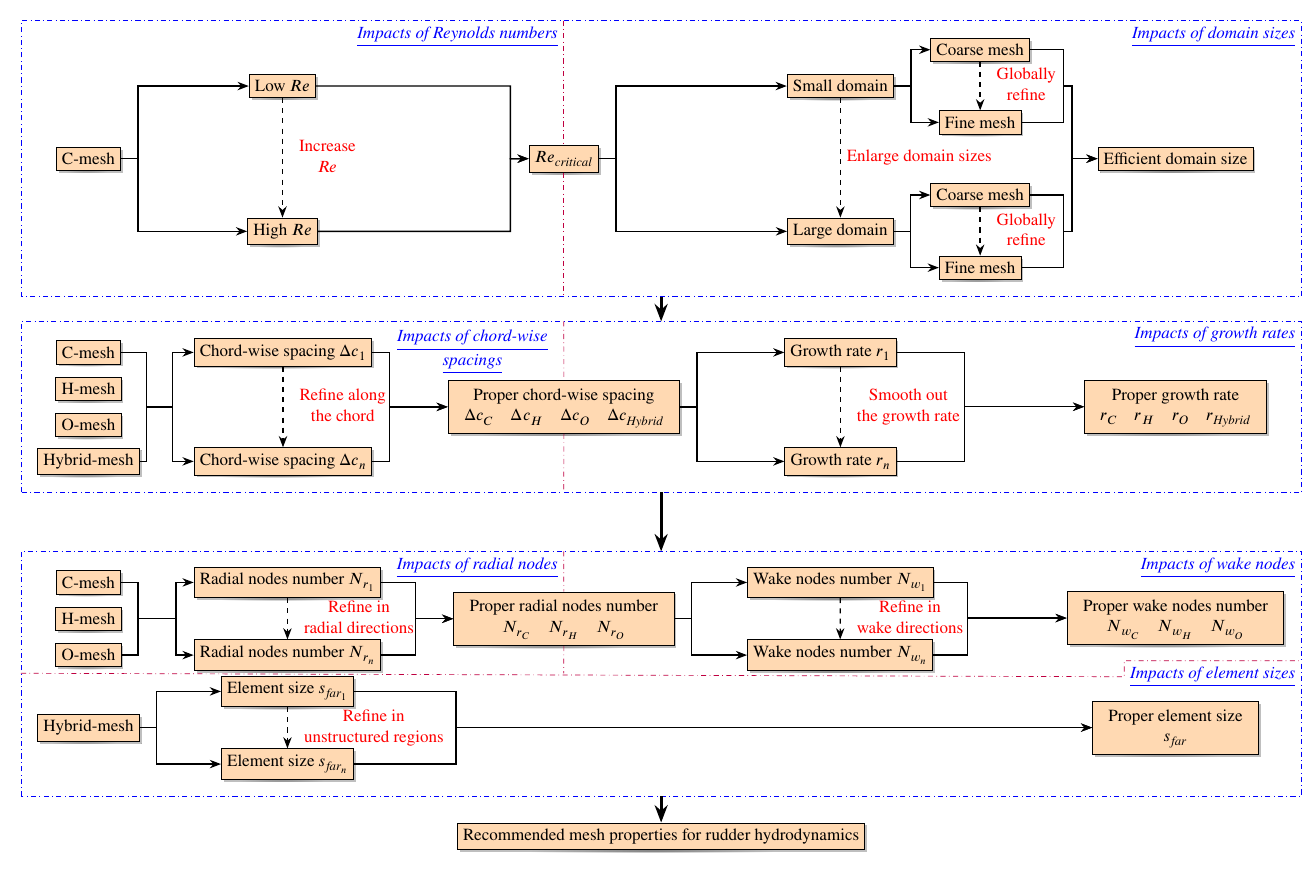
Figure 6. Strategy applied to study different mesh properties. Table 3. Numerical settings for RANS simulations with